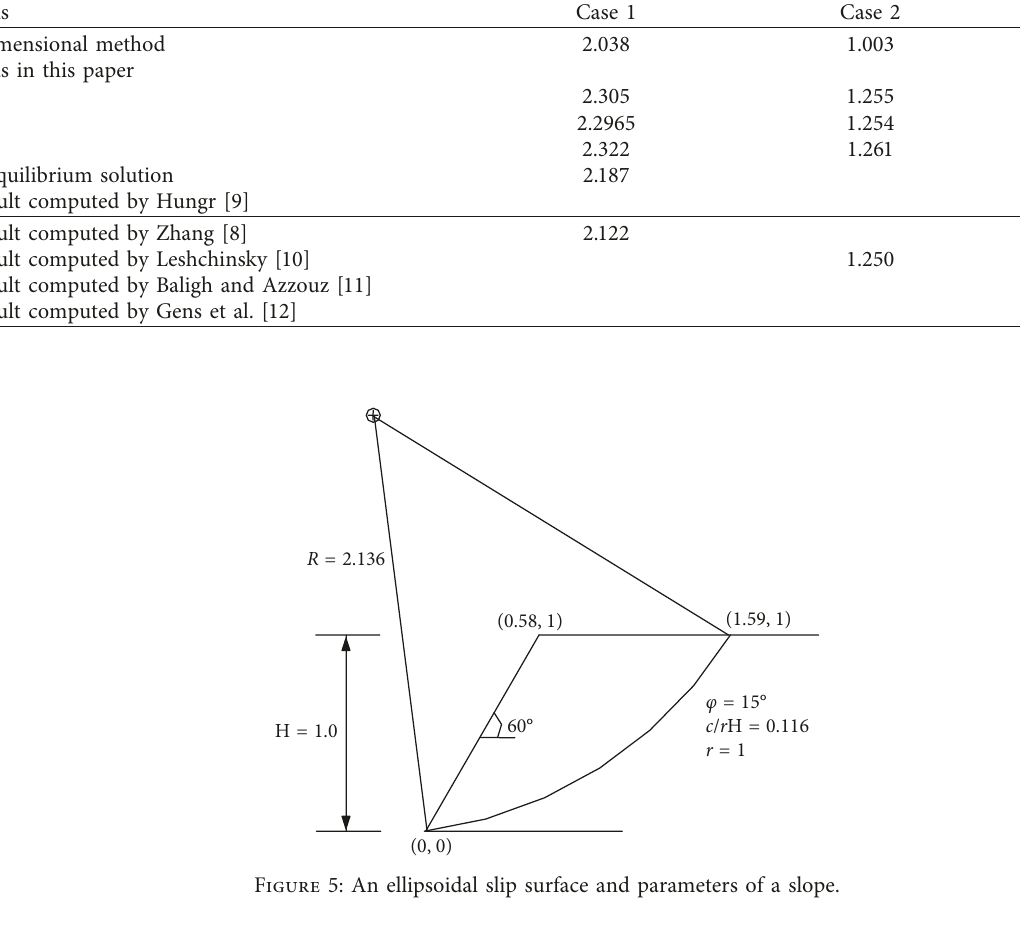
Table 1: The comparison of the calculated safety factor for cases.